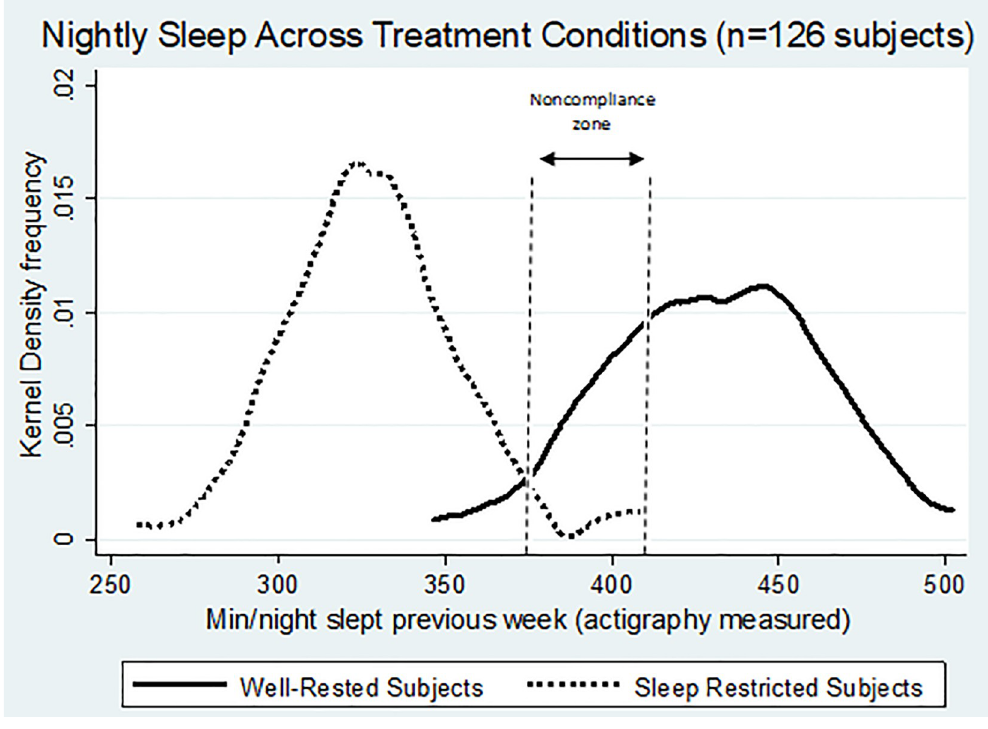
Fig 1. Sleep levels by treatment